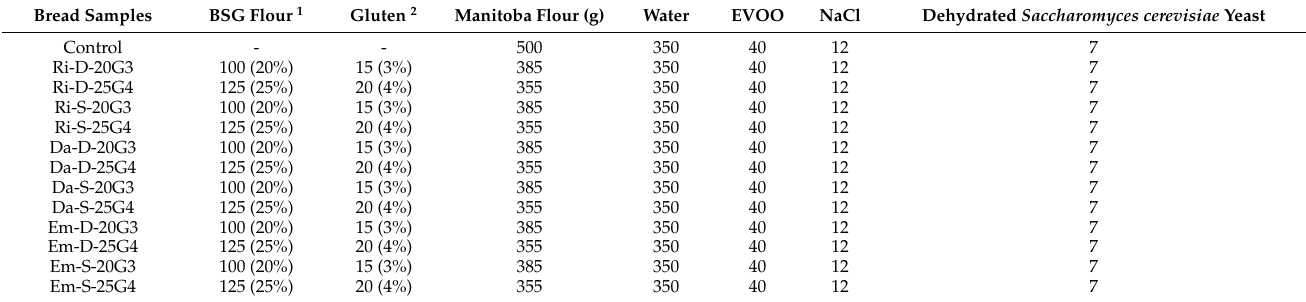
Table 2. Ingredients (g) used in bread formulations.